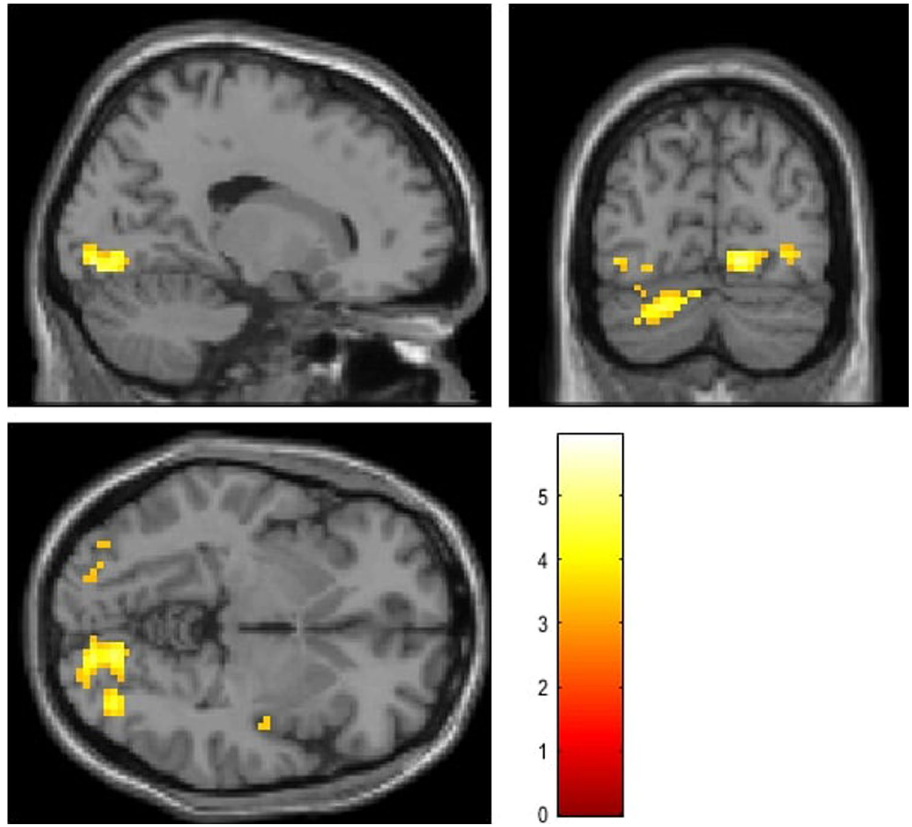
Figure 4. fMRI results of paired t-test for ES > MS for contrast correct rejection of lure > false alarms in the retrieval phase ( p < .05, FDR corrected on the cluster level).